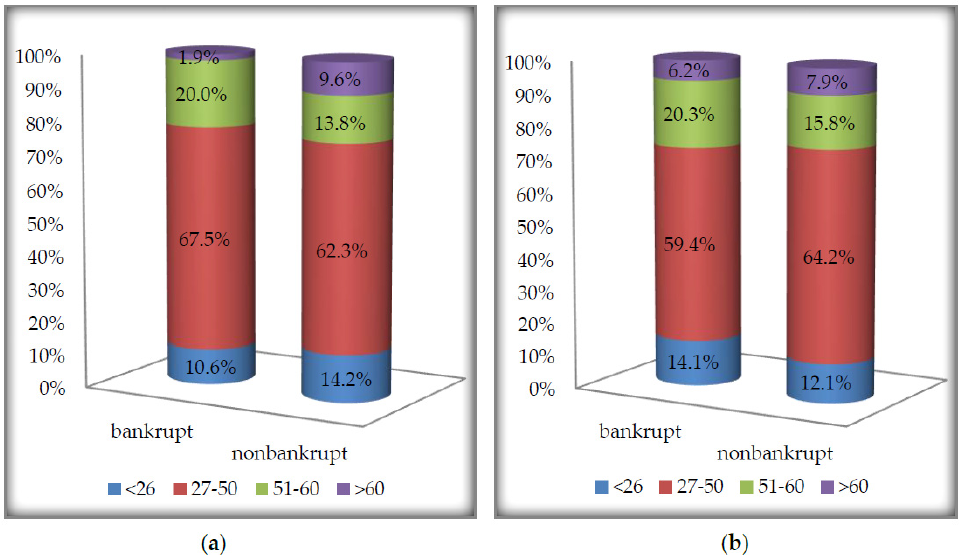
Figure 1. The age structure of bankrupt and nonbankrupt consumers in Poland, in testing samples of: ( a ) female and ( b ) male. Source: Based on own studies.